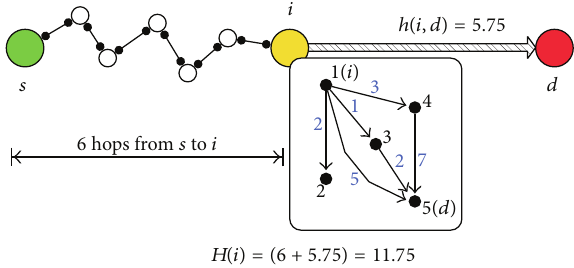
Figure 4: The heuristic value calculation